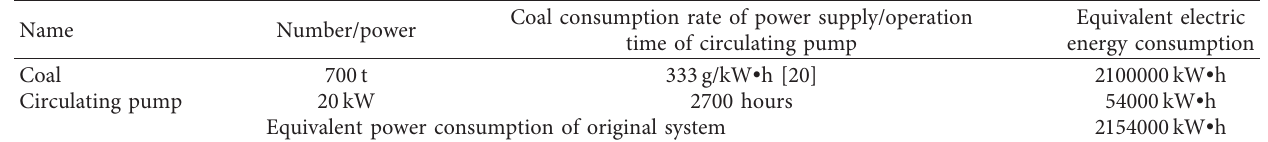
Table 7: Energy consumption of original system.